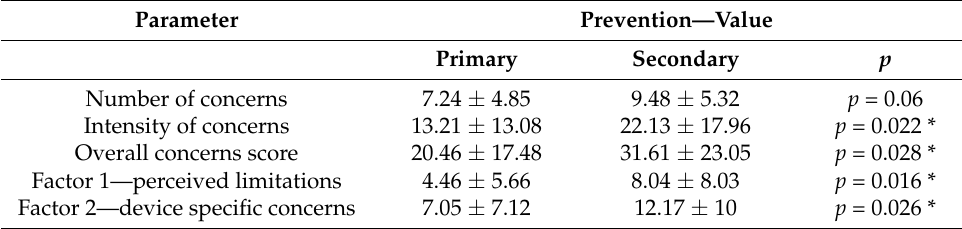
Table 5. The type of prevention versus the number and intensity of any